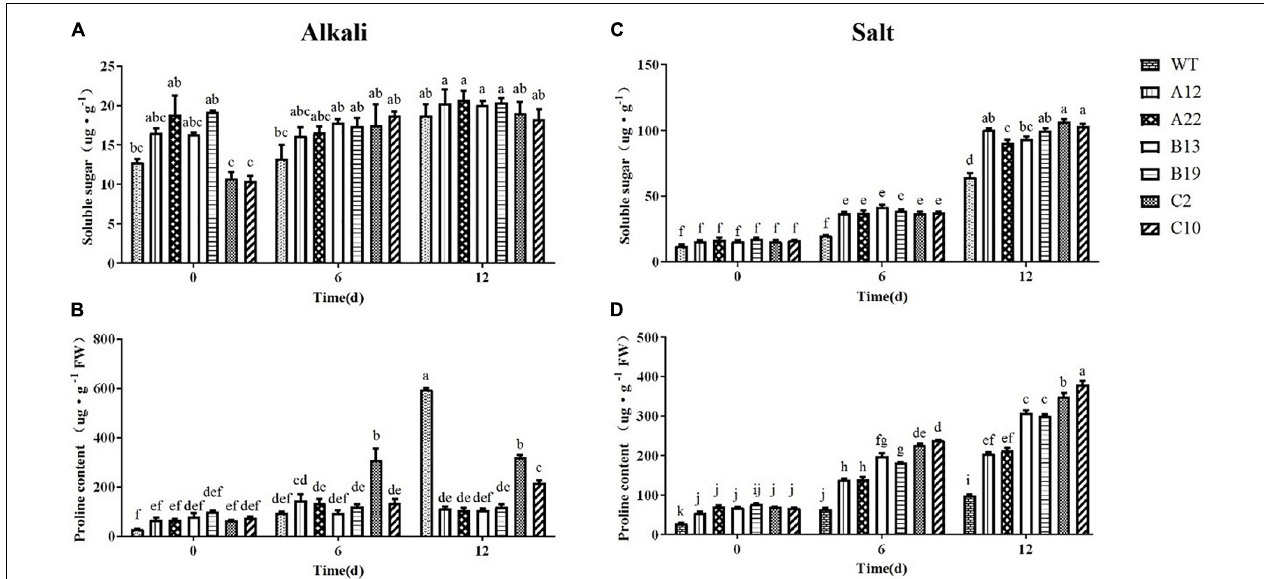
FIGURE 4 | Contents of soluble sugars and Pro in WT and transgenic alfalfa plants before and after alkali and salt treatments. Comparisons of soluble sugar contents (A,C) and Pro contents (B,D) of WT and transgenic alfalfa plants before and after 6- and 12-days alkali and salt treatments. The values are the means ± SDs of three replicates (Duncan test: P <